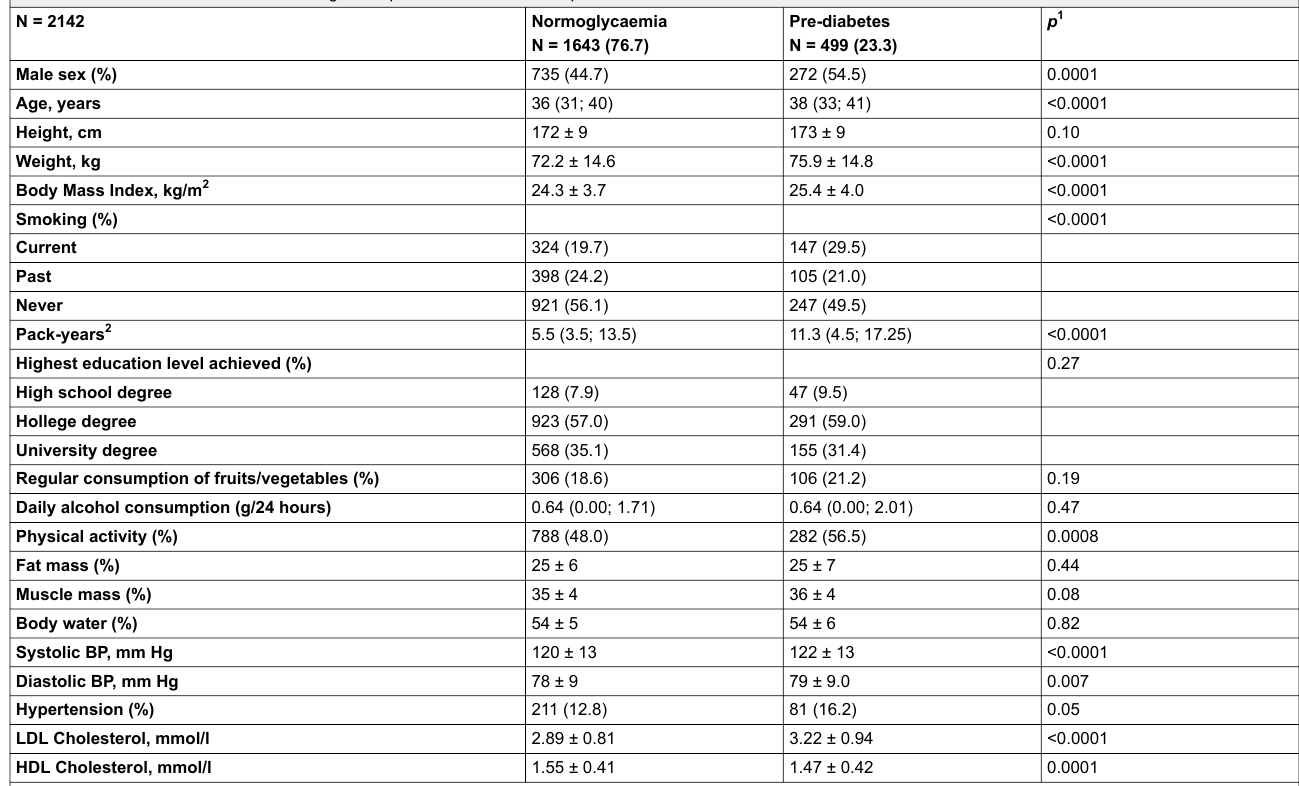
Table 1: Baseline characteristics according to the presence or absence of pre-diabetes. N = 2142